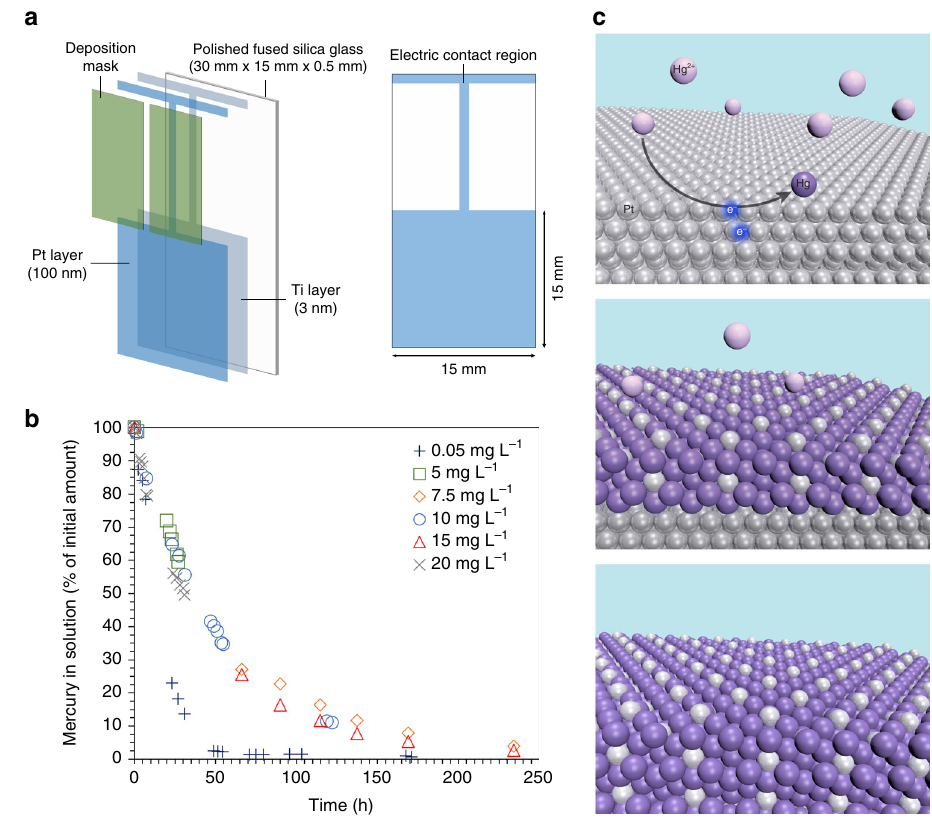
Fig. 1 Electrochemical alloy formation between divalent mercury in solution and metallic platinum. a Schematic representation of the platinum nano- fi lm electrodes used. b The in fl uence of initial mercury concentration in solution on the decontamination ef fi ciency. The electrolytes were 50mL 1mol L − 1 nitric acid solution with 0.05 — 20mg L − 1 mercury, as follows: 0.05mg L − 1 (dark-blue pluses), 5mg L − 1 (green squares), 7.5mg L − 1 (orange diamonds), 10mg L − 1 (blue circles), 15 mg L − 1 (red triangles), and 20 mg L − 1 (grey crosses). Working electrode: 100 nm platinum fi lm (2.25 cm 2 area). Counter electrode: platinum wire. Reference electrode: Hg/Hg 2 SO 4 . Potential = 0.16 V vs. RHE. c Schematic representation of the alloying process. Divalent mercury ions in solution (light purple colour) are fi rst reduced on the platinum surface (silver colour) to elemental mercury. Elemental mercury (darker purple) forms thermodynamically stable PtHg 4 with the platinum atoms. Upon formation of the fi rst layers of PtHg 4 , mercury atoms penetrate the metallic alloy fi lm